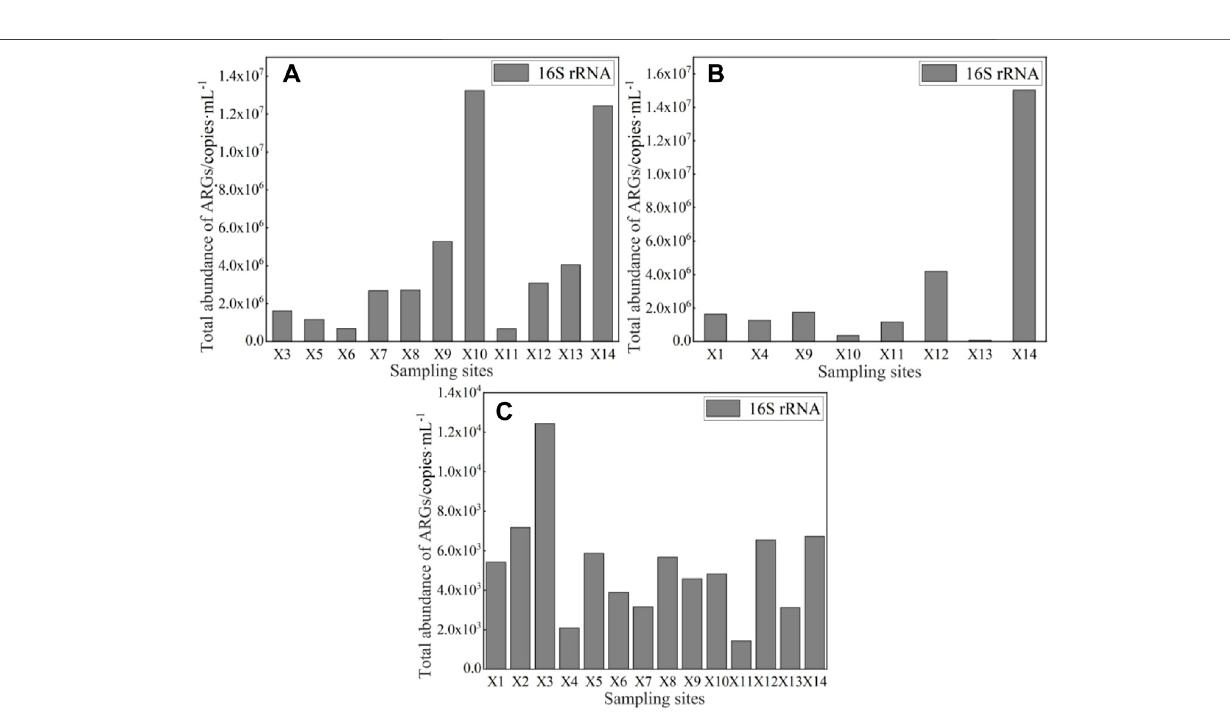
Frontiers in Environmental Science |